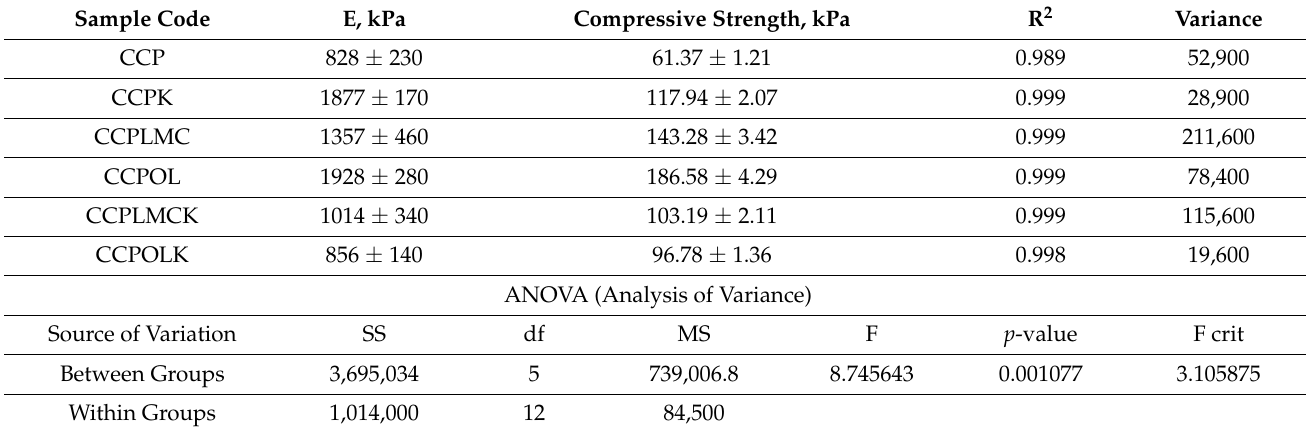
Figure 4. ( A , B ) Stress–strain curves obtained upon uniaxial compression onto swollen CCP-based hydrogels; ( C , D ) linear part of stress–strain curves from which the compressive Young’s modulus of all hydrogel samples was calculated. Table 2. Values of the compressive Young’s modulus (E, MPa) and compressive strength of the swollen CCP-based hydrogels.